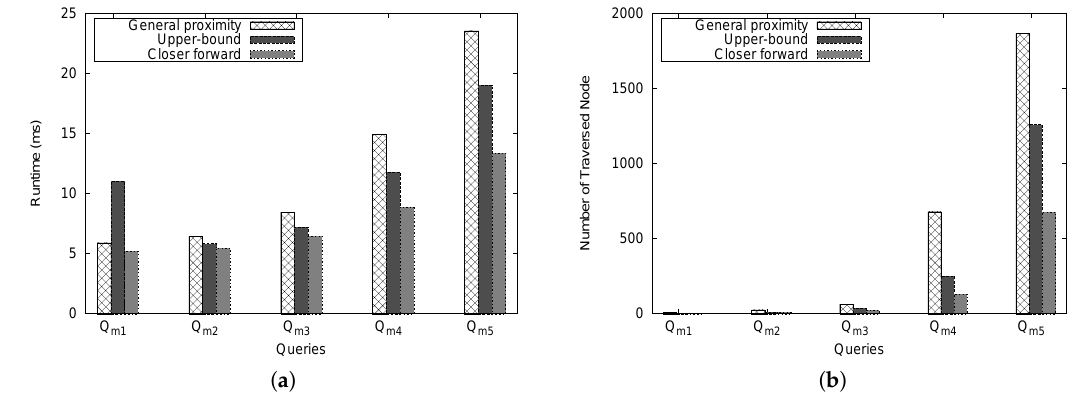
Figure 20. Mountain-separated case. ( a ) execution time; ( b ) number of traversed